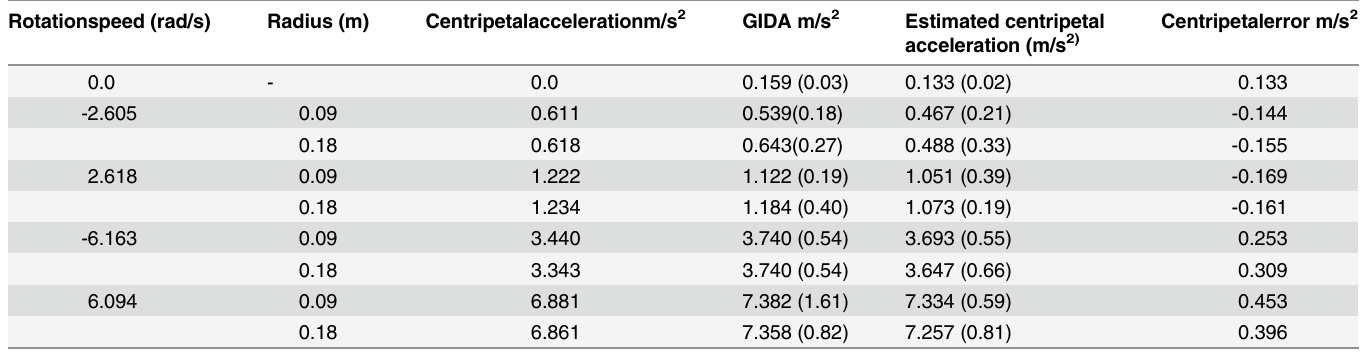
Table 3. Results from the lathe test rig with estimated centripetal accelerations compared to actual centripetal accelerations. Standard deviations are given in brackets. Rotationspeed